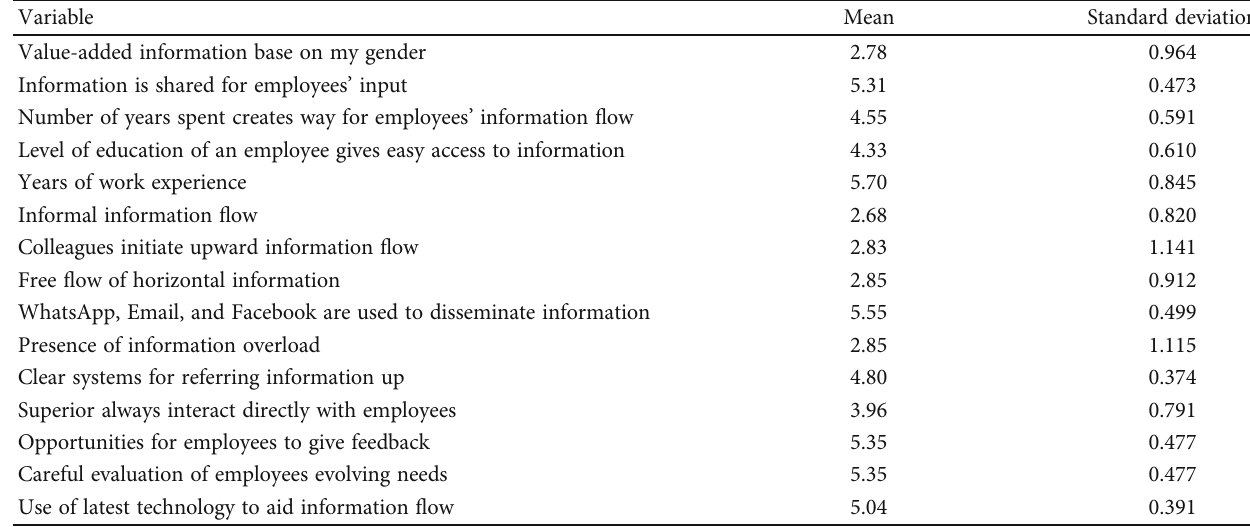
Table 1: Role of internal communication on employee decision-making